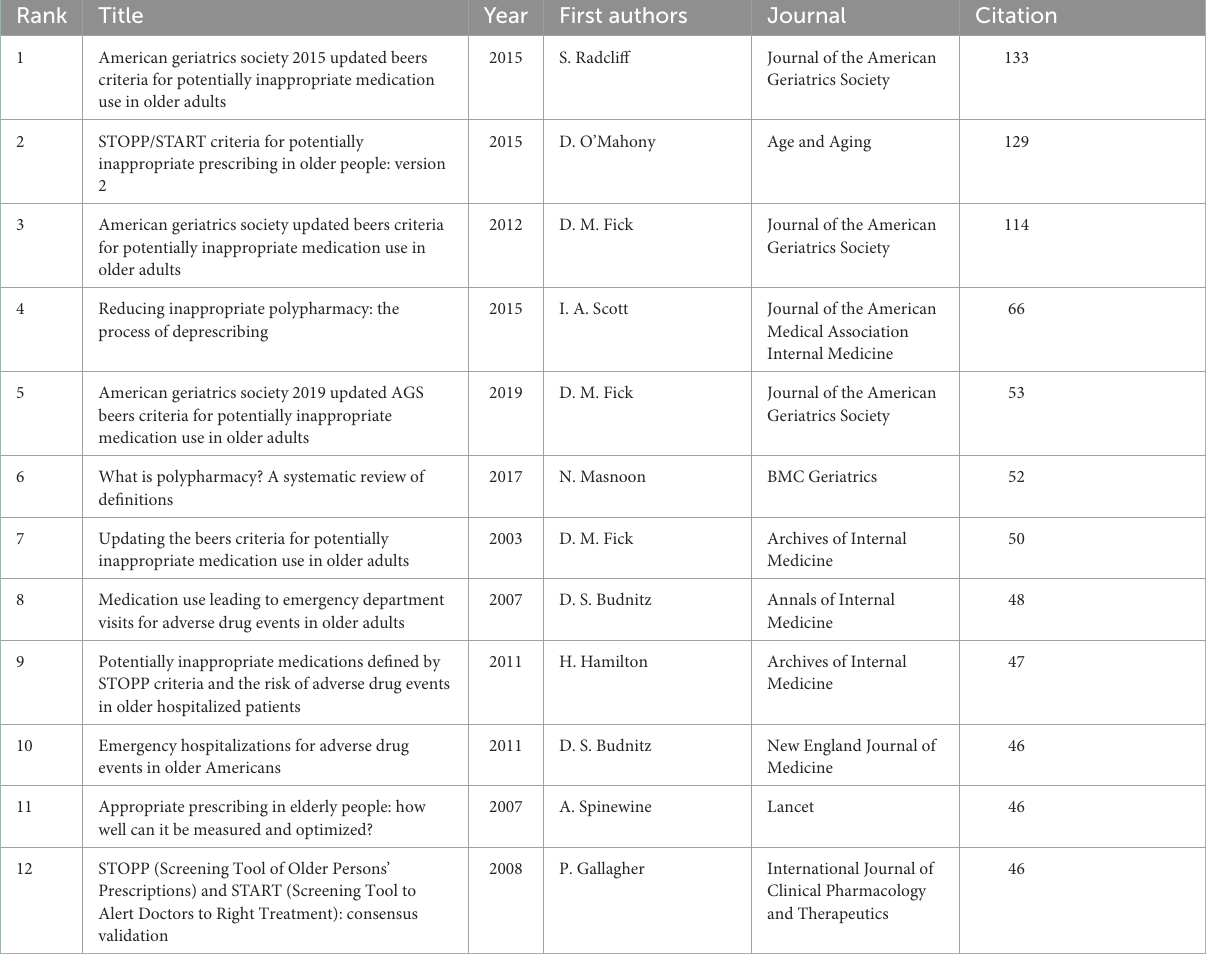
TABLE 5 Top 12 cited references in studies on medication safety for older